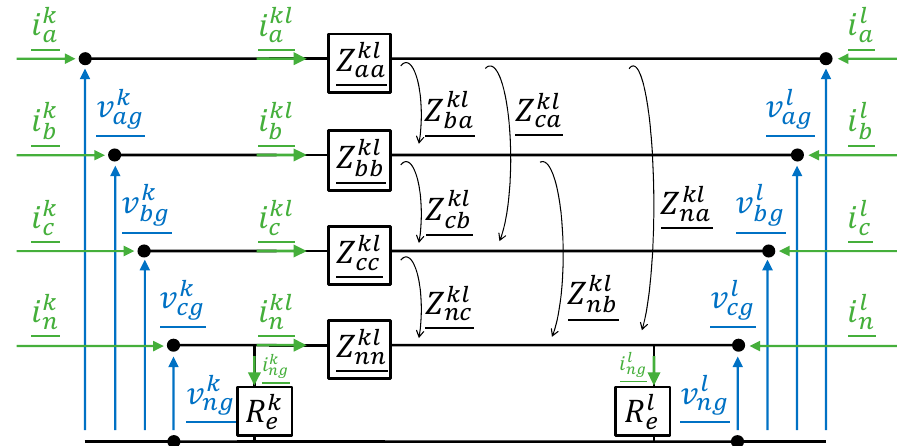
Figure 3. 4 CMext of LV cable. Series Impedance